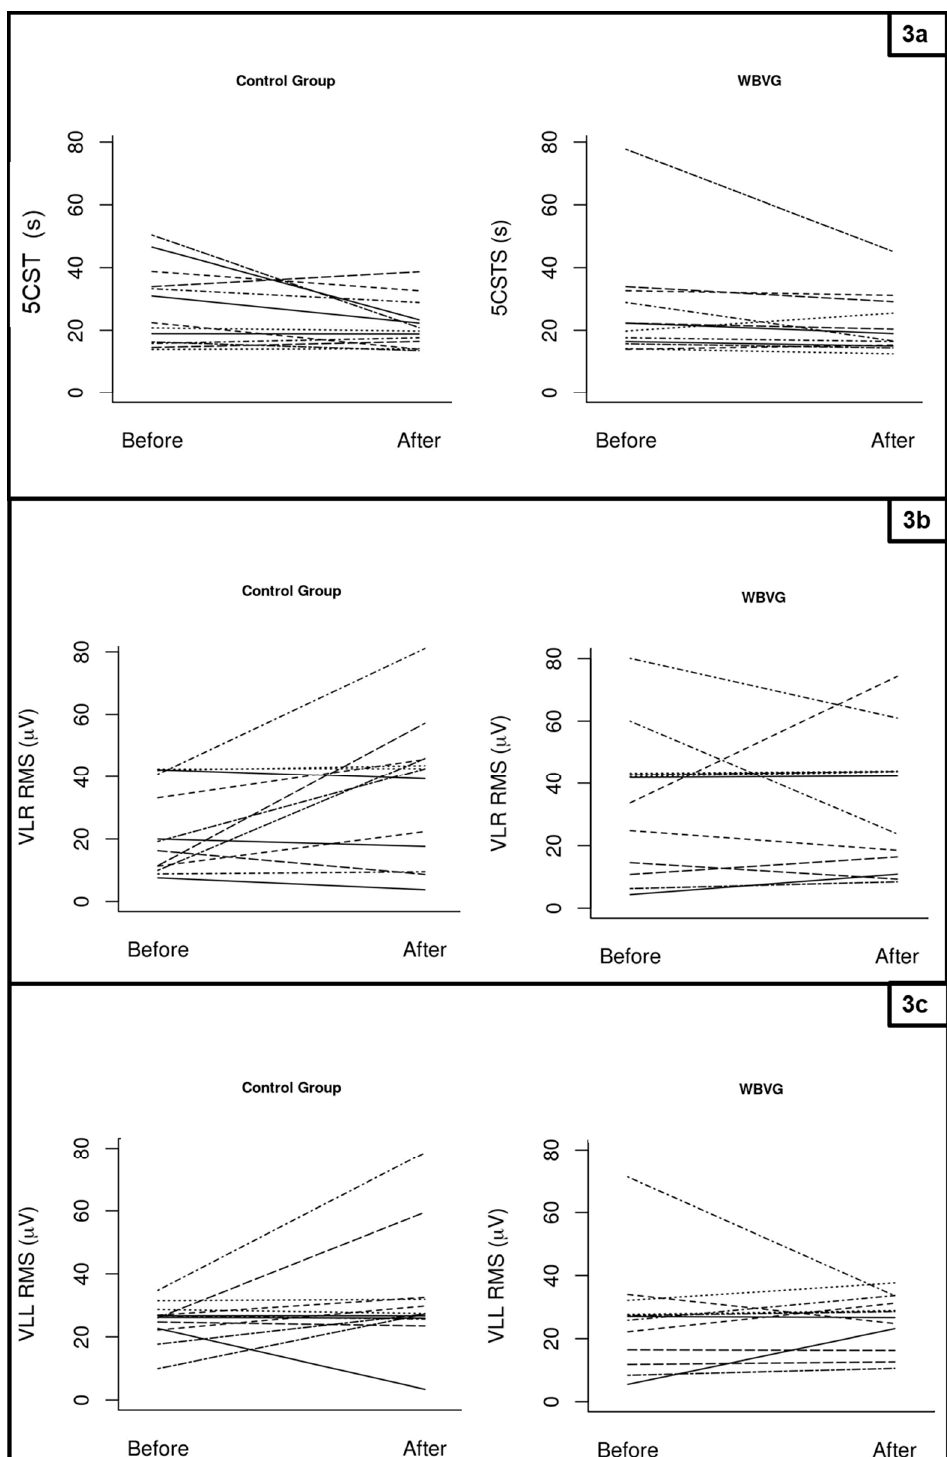
Figure 3. Outcome measures before and after intervention: ( a ) execution time of five-repetition chair stand test, ( b ) electromyographic activity of the vastus lateralis right, and ( c ) electromyographic activity of the vastus lateralis left. Legend: 5CST—five-repetition chair stand test; VLR—vastus lateralis right; VLL—vastus lateralis left; control group (n = 19); WBVG—vibration group (n = 16); RMS—root mean square. p < 0.05.